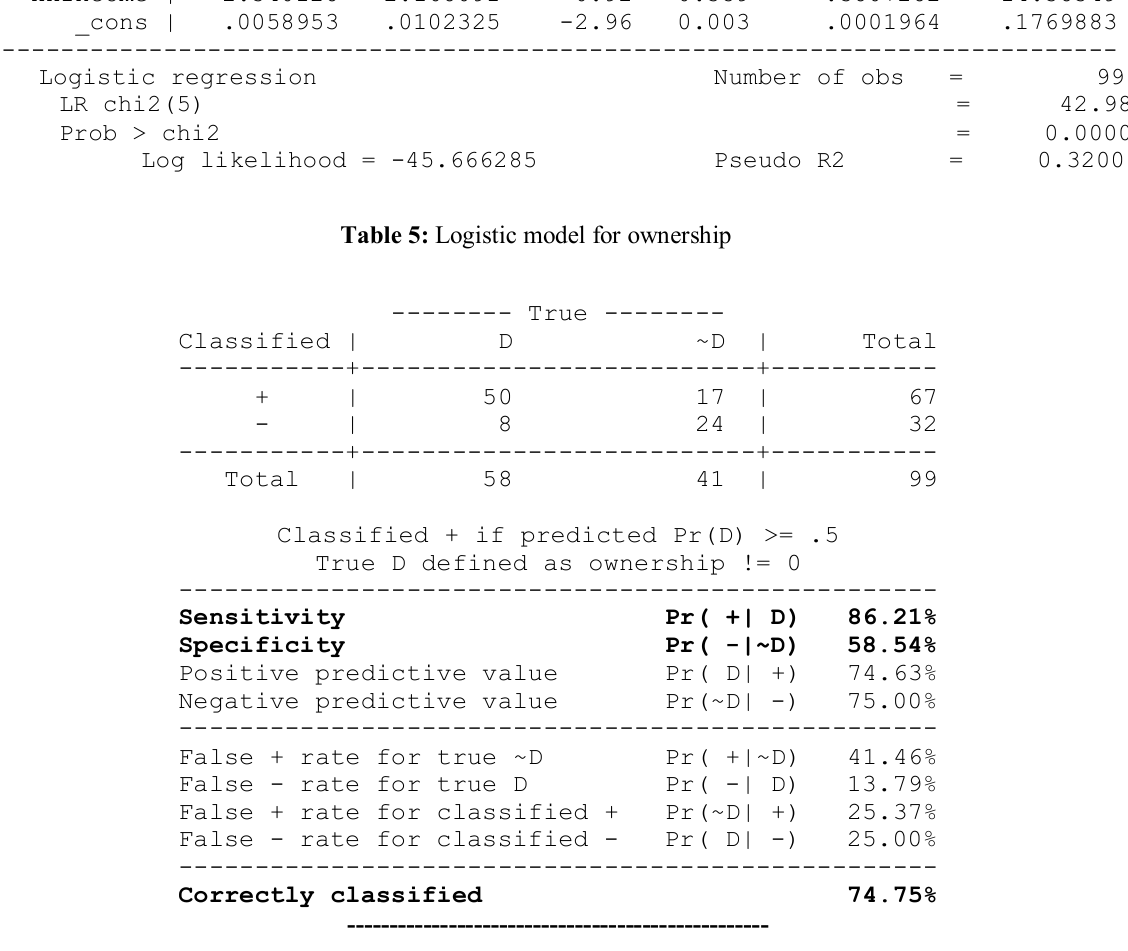
Table 6: Logistic model for ownership, goodness-of-fit